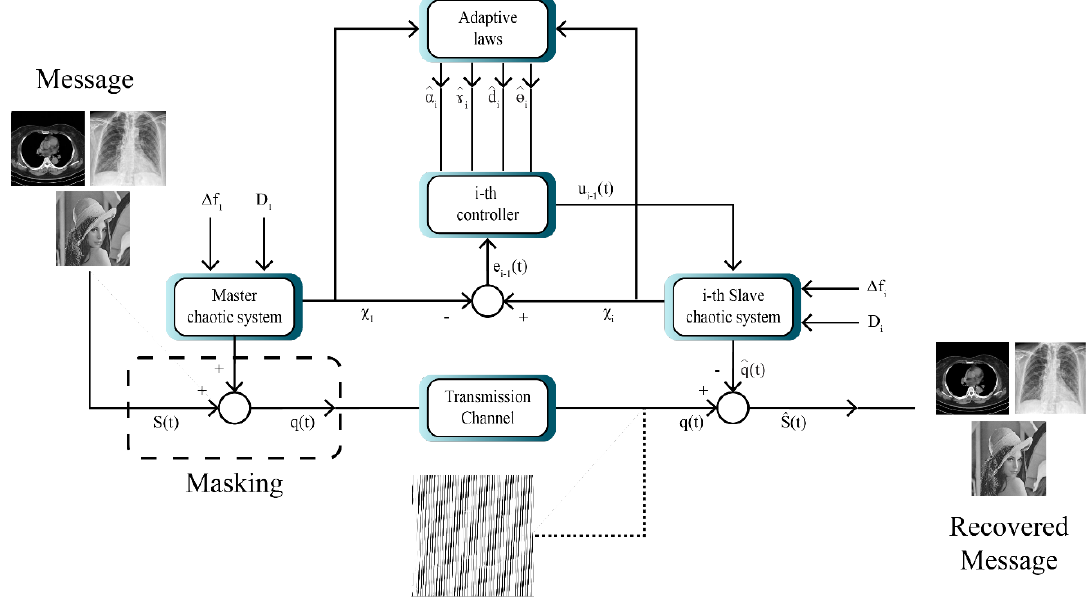
Figure 3. Block diagram of chaotic masking with the aid of multi-state synchronization.